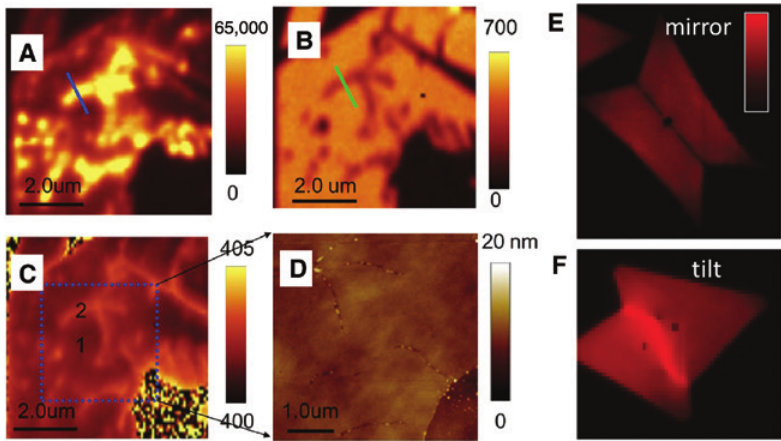
peak intensity (B), and A ′ peak frequency (C) images of a monolayer MoS Figure 10: PL intensity (A), Raman A ′ 1 1 at 500 ° C at 0.1 Pa. (D) AFM image corresponding to the blue square in (C). Reprinted with permission from [33]. Copyright 2014 American Chemical Society. PL intensity images of CVD MoS islands with mirror (E) and tilt (F) GBs. The mirror twin boundary has a 50% quenching of 2 PL, while the tilt boundary has a 100% enhancement of PL. Reprinted with permission from [57]. Copyright 2013 Nature Publishing